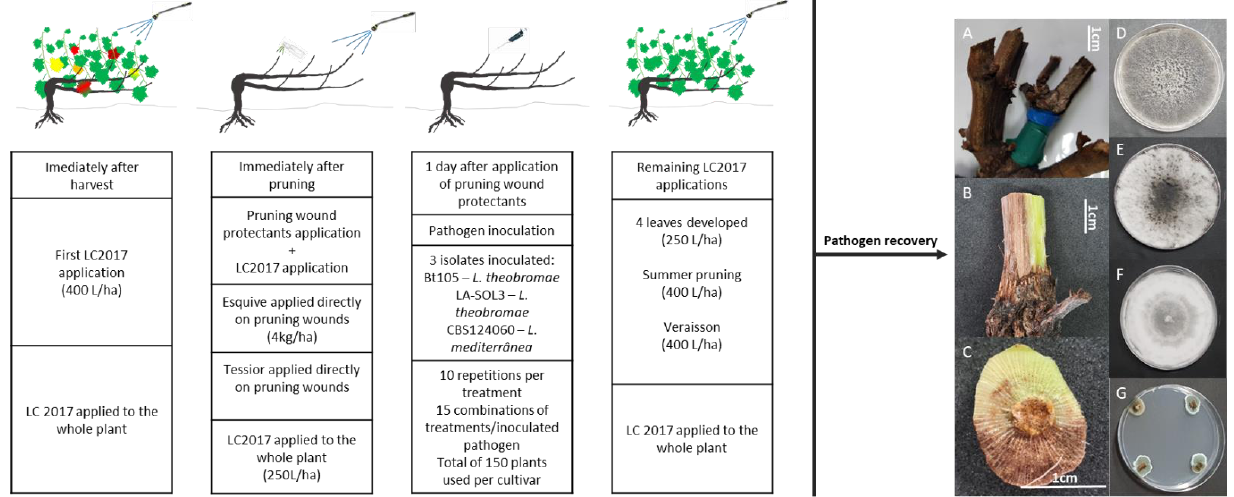
Figure 5. Diagram showing the several steps of the field assay. Information on the products used can be found in Table 4, and a description of the different treatments can be found in Table 5. A : Marked sample collected from the field prior to analysis; B : Sample with the bark removed showing sign of necrosis; C : Sample collected about 1 cm below the pruning wound, to be divided into four pieces and plated onto PDA; D : Isolate Bt105 ( Lasiodiplodia theobromae ) recovered from infected pruning wounds; E : Isolate LA-SOL3 ( Lasiodiplodia theobromae ) recovered from infected pruning wounds; F : Isolate CBS124060 ( Lasiodiplodia mediterranea ) recovered from infected pruning wounds; G : Petri dish containing wood obtained from non-inoculated control plants showing no signs of pathogen growth.